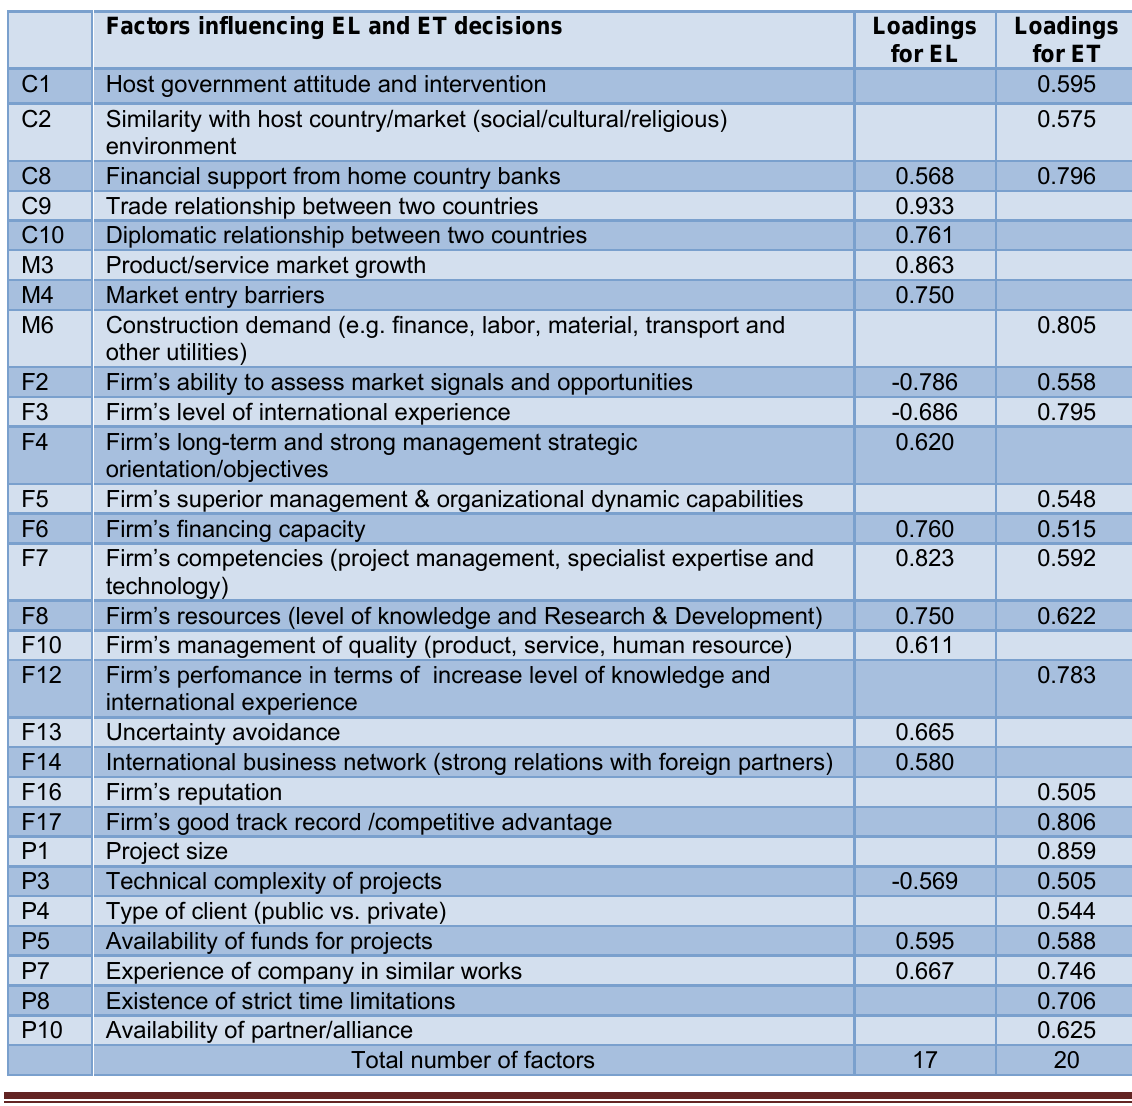
Table 12: Summary of significant factors influencing EL and ET decisions based on factor